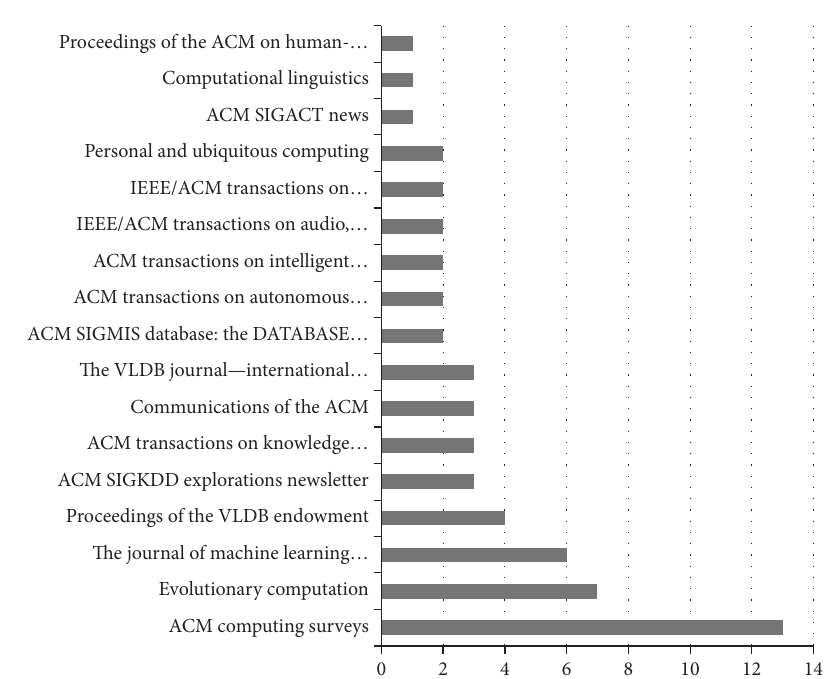
Figure 4: Initial results of the journal/magazine names along with the total number of